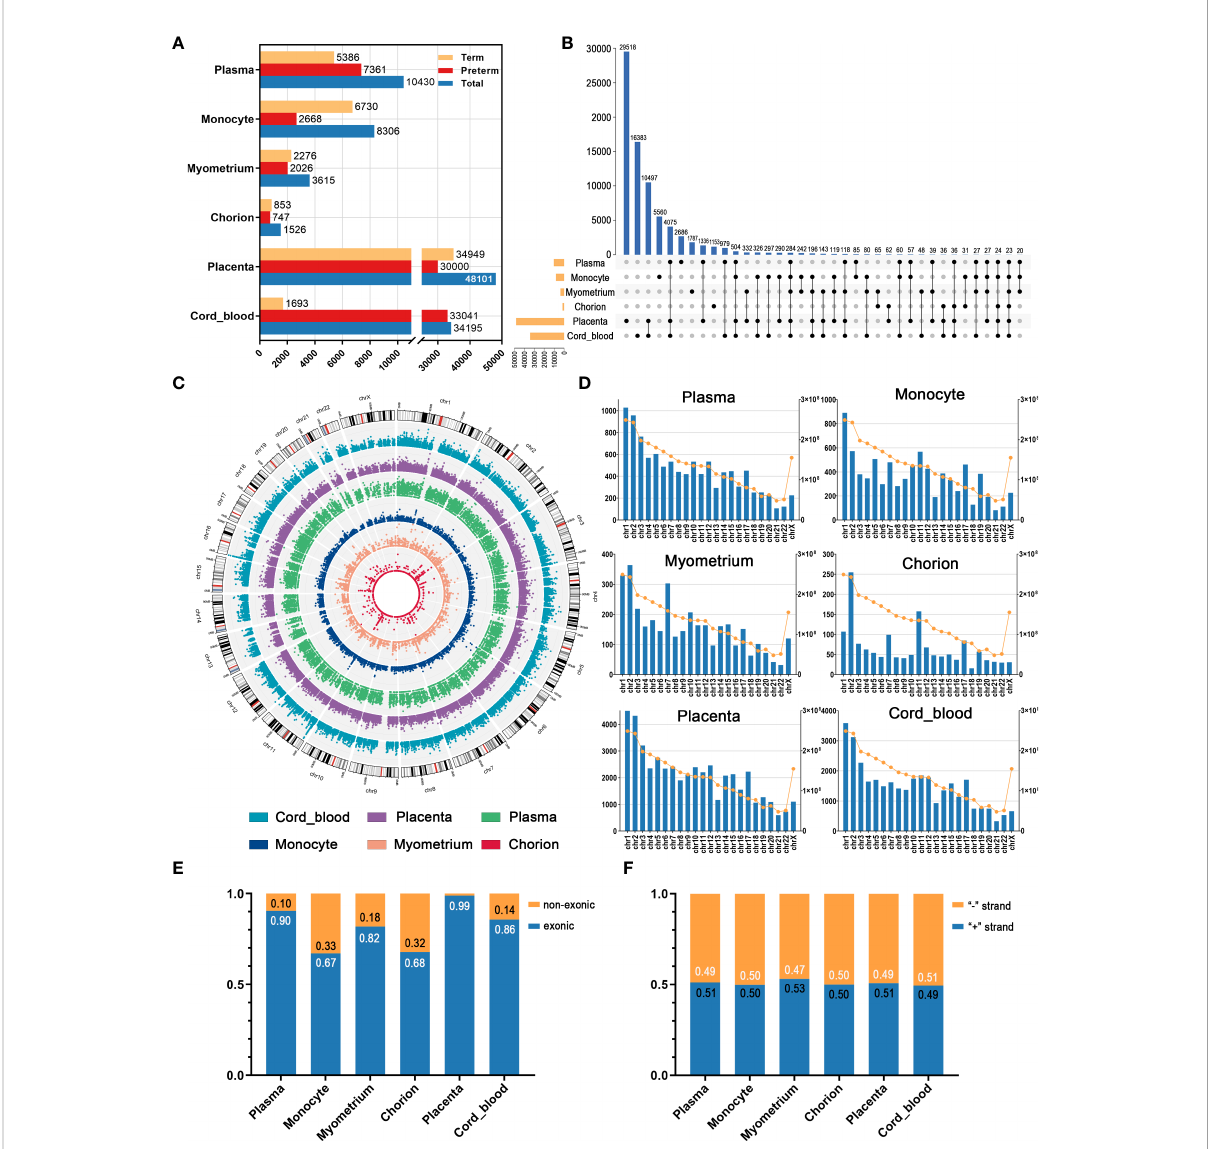
FIGURE 1 The overview of circRNAs in maternal plasma, maternal monocytes, myometrium, chorion, placenta, and cord blood of preterm and term pregnancies. (A) The number of circRNAs in different groups and tissue types. (B) The intersection of circRNAs in various tissues. (C) The chromosomal distribution patterns of circRNAs in different tissues. (D) The length and circRNA number per chromosome. The blue bars indicate the circRNA number (left Y axis) and the yellow dots indicate the chromosome length (right Y axis). (E) The proportion of the non-exonic and exonic circRNAs. (F) The ratio of sense and antisense strand